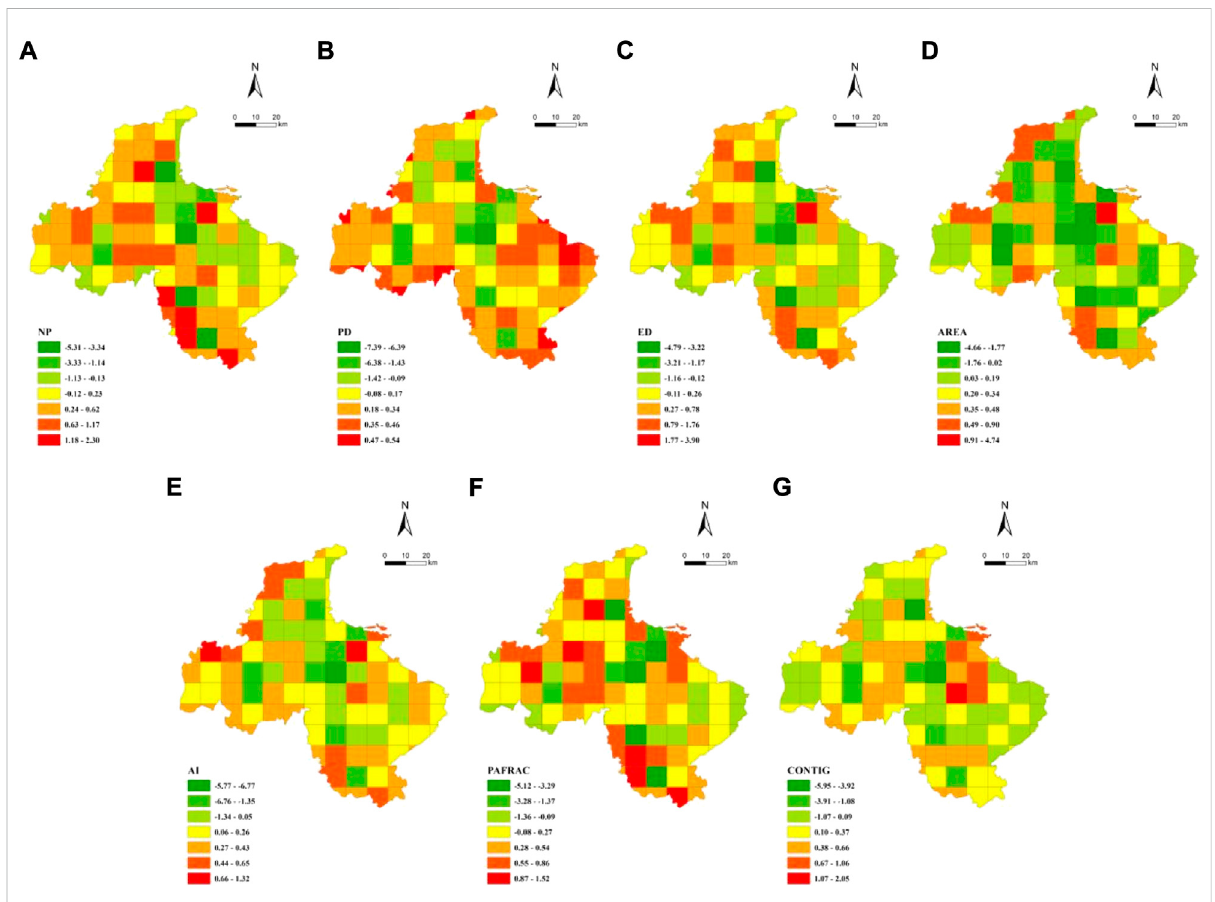
FIGURE 3 (A-G) Spatial distribution of POI density and GWR model coef fi cient of urban forest landscape pattern